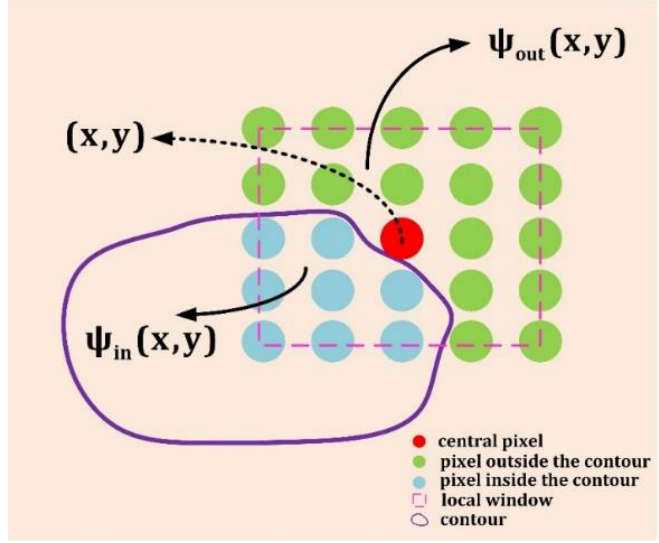
ψ ( x , y ) , where ψ ( x , y ) and ψ ( x , y ) and i n i n o u t